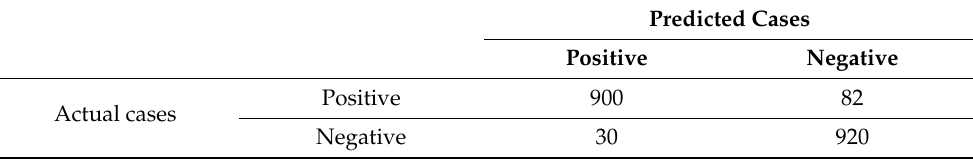
Table 6. The confusion matrix denotes the accuracy of the model using the SERV-112 set.